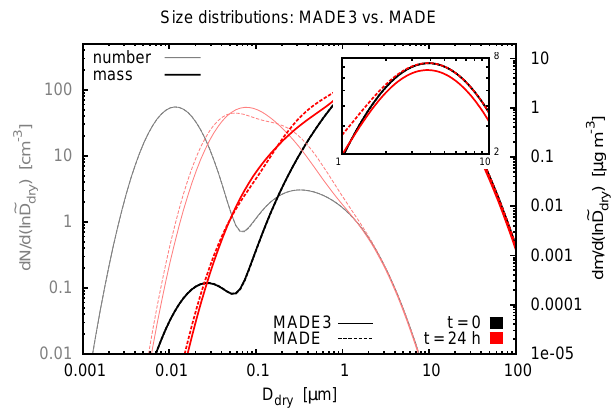
Figure 3. Initial (grey, black) and final (light red, red) size distri- butions in MADE3 and MADE vs. dry diameter (i.e. neglecting aerosol water). Light colours (grey, light red) are used for num- ber distributions (left vertical axis), full colours (black, red) for dry mass distributions (right vertical axis). MADE3 output is shown as solid lines, MADE output as dashed lines. The inset magnifies the coarse mode dry mass size